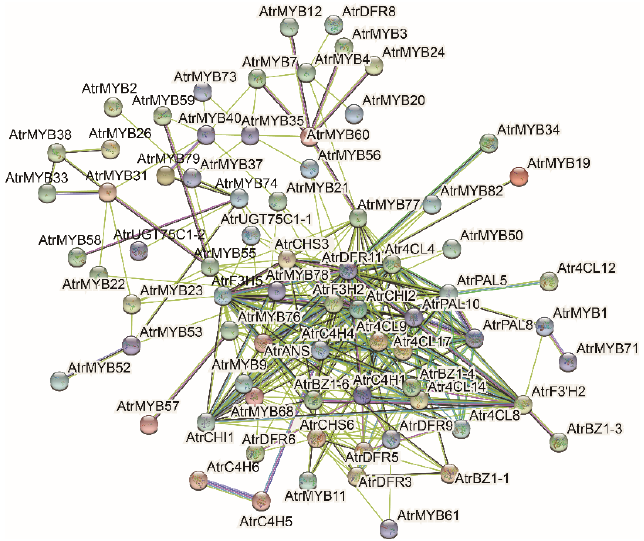
Figure 9. The PPI (protein–protein interaction) network of differentially expressed AtrMYB and anthocyanin synthesis structural genes.